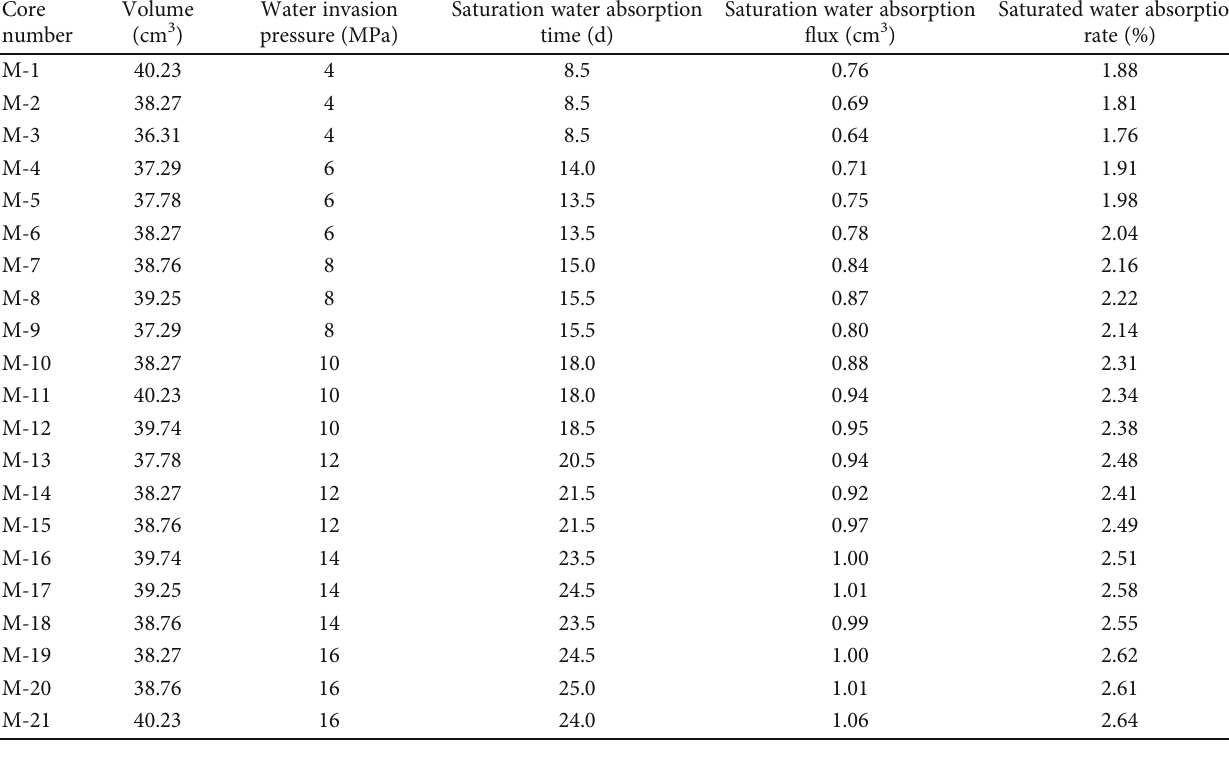
Table 2: Experimental results of the mudstone water absorption.